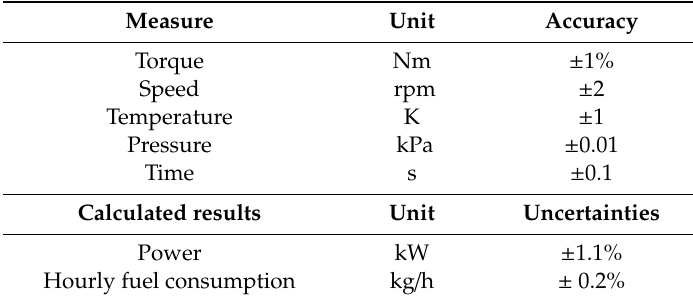
Table A1. Measurement accuracies and result